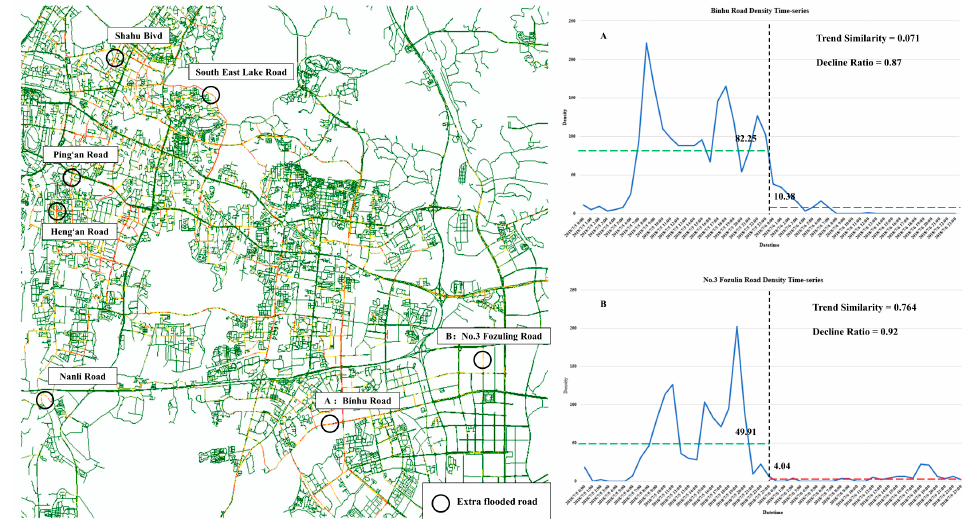
Figure 11. The additional flooded roads and their density–time series. ( A ) The density time-series of Binghu Road. ( B ) The density time-series of No.3 Fozulin Road.